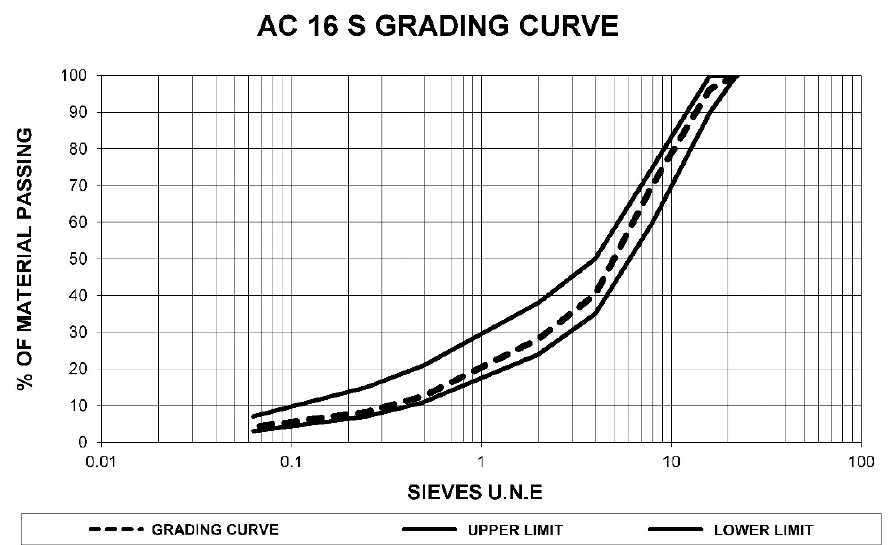
Figure 1. Grading AC16S grading curve referring to the grading envelope defined by the standard ORDER FOM/2523/2014.